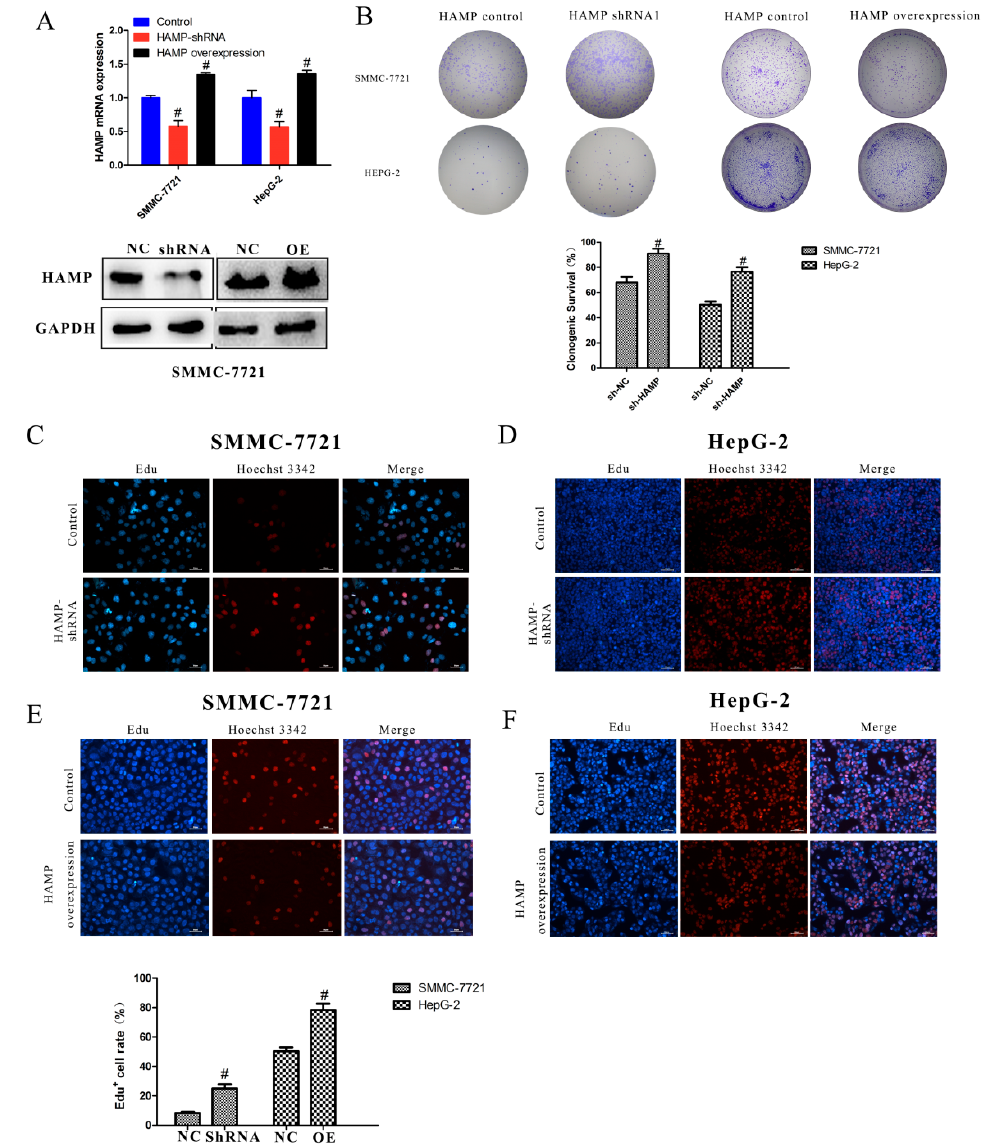
Figure 2. The e ff ect of HAMP on proliferation. ( A ) Analysis of HAMP expression in SMMC-7721 / HepG-2 cells after transfection with control, HAMP shRNA, and HAMP overexpression vector. ( B ) A tumor colony forming assay was used to detect the proliferation of SMMC-7721 and HepG-2 cells after knockdown or overexpressed the HAMP gene expression. ( C – F ) 5-ethynyl-20-deoxyuridine (EdU) incorporation assay was employed to detect the viability of SMMC-7721 / HepG-2 cells transfected with control, HAMP shRNA, and HAMP overexpression vector. # p < 0.05. Scale bar = 50 µM